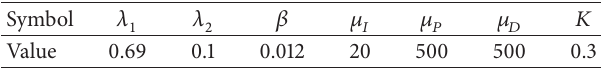
Table 2: Control parameters for deceleration brake.